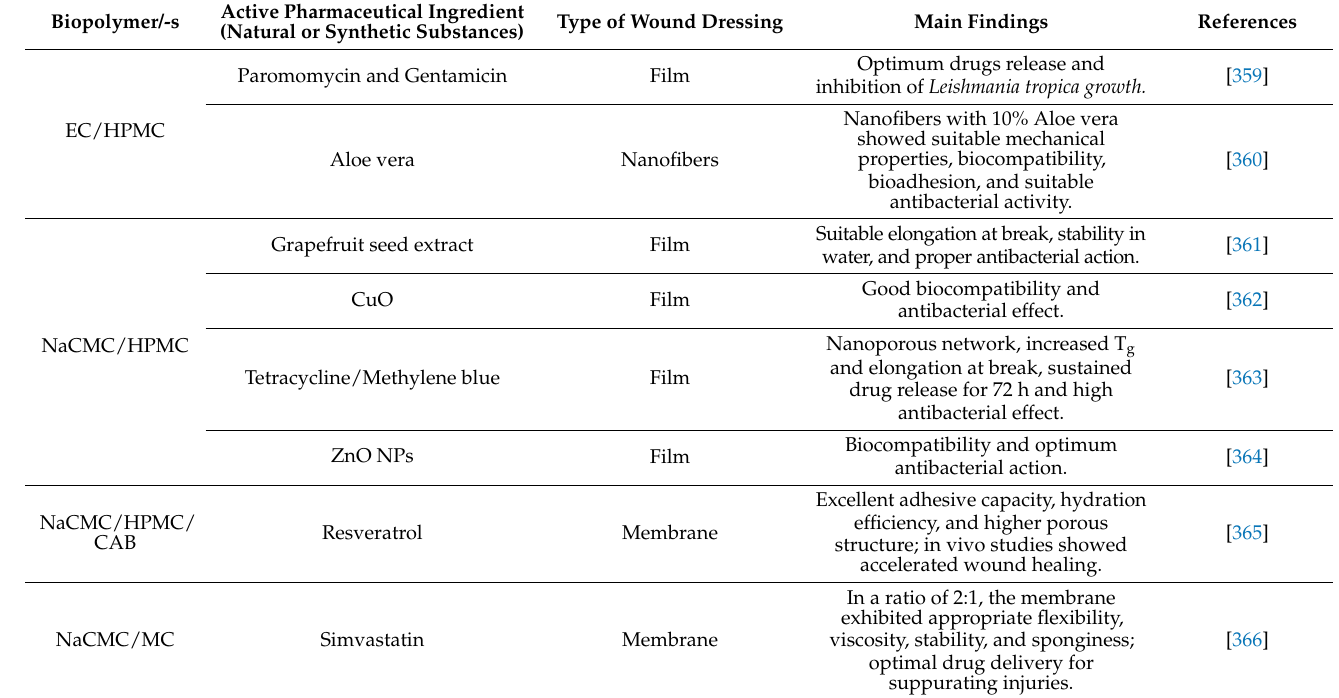
Table 9. Recent studies on the use of combinations of cellulose derivatives as wound dressing.